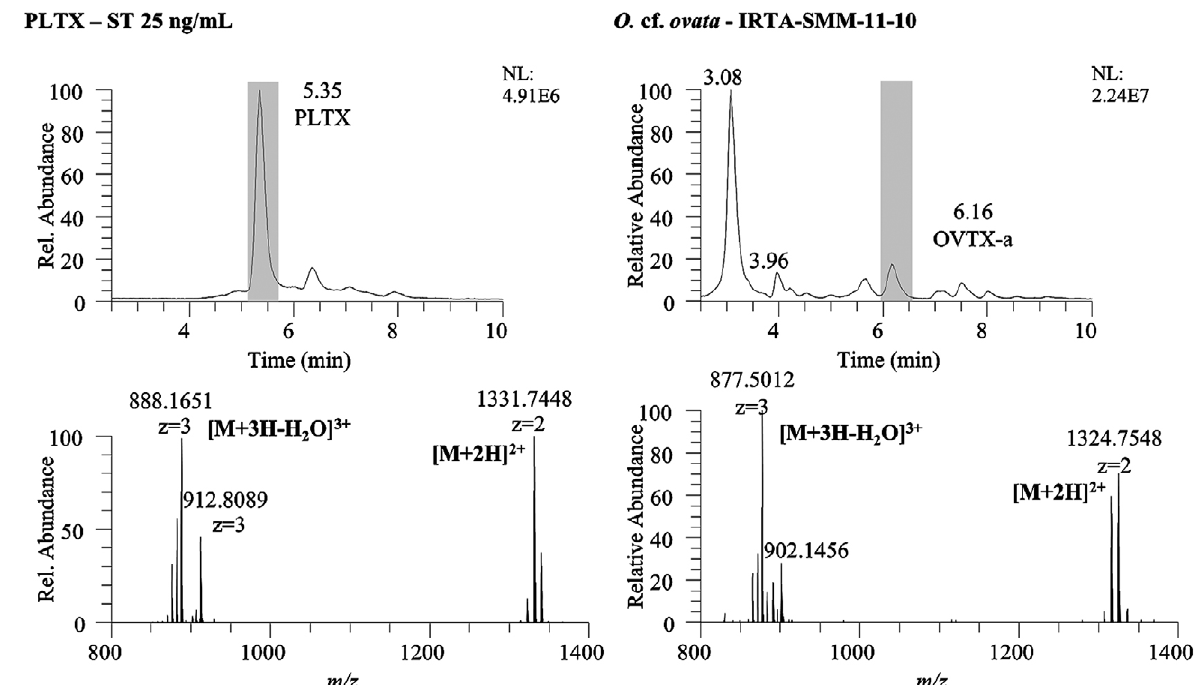
Fig. 6. – LC-HRMS analysis (total ion chromatograms and full scan MS) of PLTX standard (25 ng mL –1 from Palythoa tuberculosa ) and methanolic extracts of Ostreopsis cf. ovata strain IRTA-SMM-11-10 (toxin profile described in García-Altares et al. 2014), used as a reference sample in the present study for the detection of PLTX-like